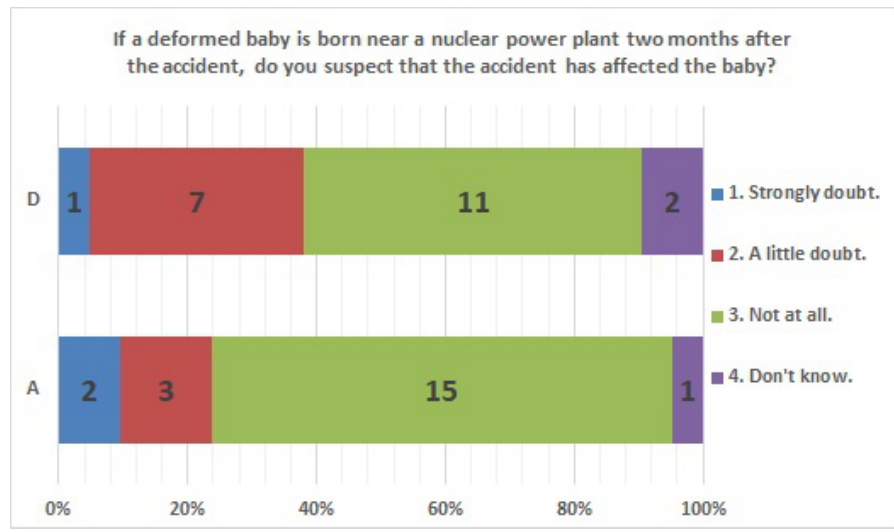
Figure 17. Responses to item No.